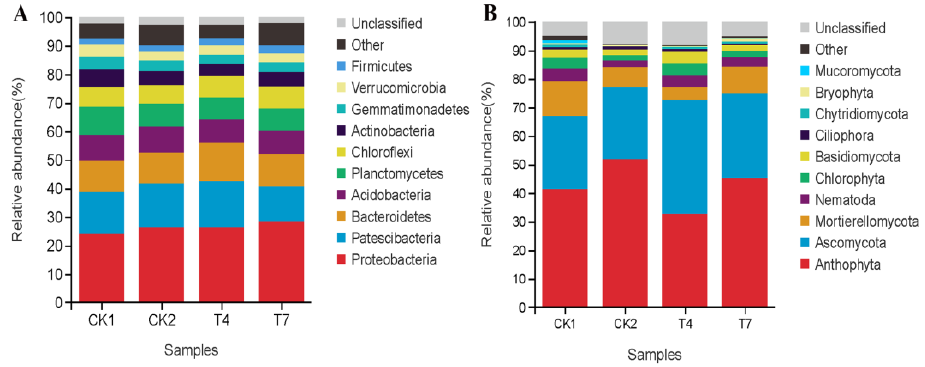
Figure 4. Composition and relative abundances of bacterial ( A ) and fungal ( B ) taxa at the phylum level.